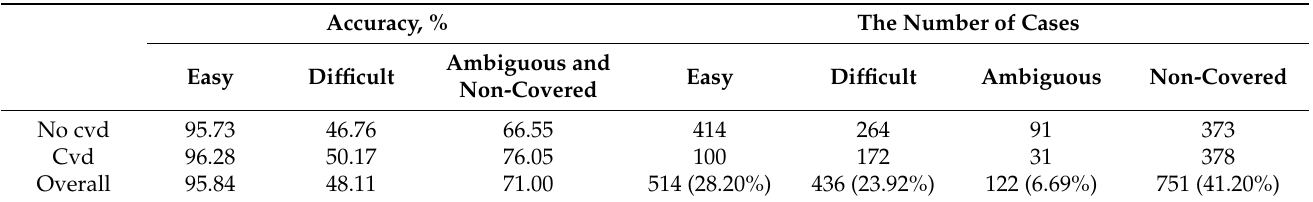
Table 2. Four categories of subjects in the KIHD sample after applying the final set of rules. The “Accuracy, %” columns represent the mean accuracy estimated in 50 runs of five-fold cross-validation. “The number of cases” columns contain the absolute number of subjects, with the percentage of the whole sample in parentheses.